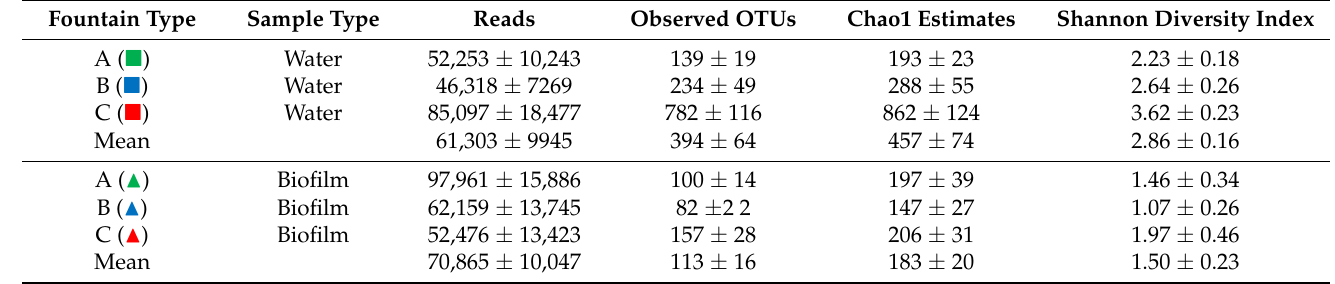
Table 2. Numbers of sequence reads and diversity indices for water and biofilm samples from drinking water fountains. For all samples, means ± SE are shown with replicates as